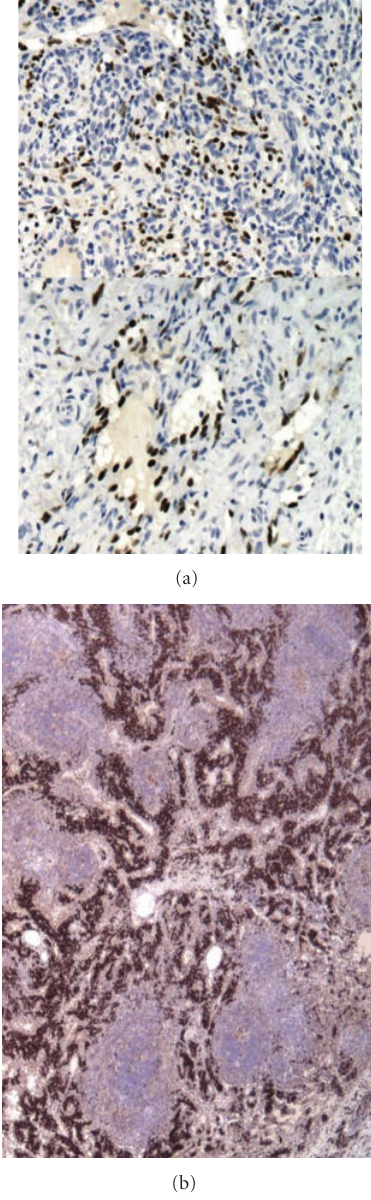
Figure 6: Lymph node with plasma cell marker VS 38 on (b) and HHV8 staining lymphoid cells on